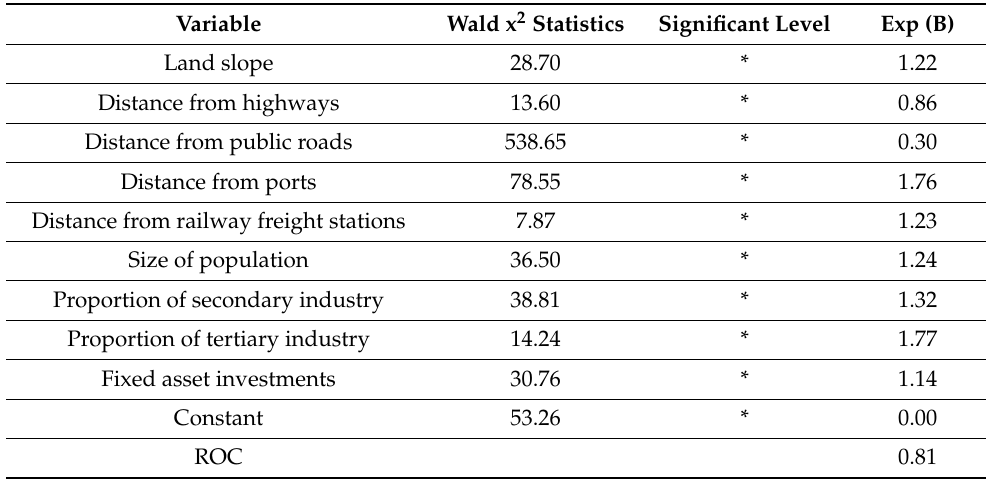
Table 4. Model estimation results of the influencing factors of industrial land use in